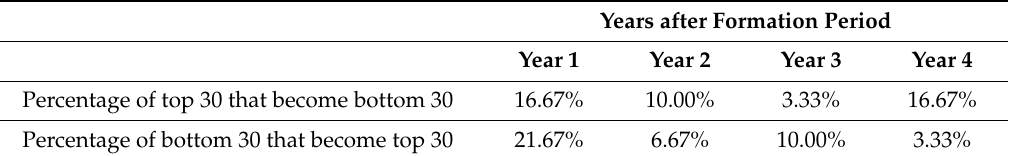
Table 6. Reversal in the alpha of the extreme 60 Japanese mutual funds Years after Formation